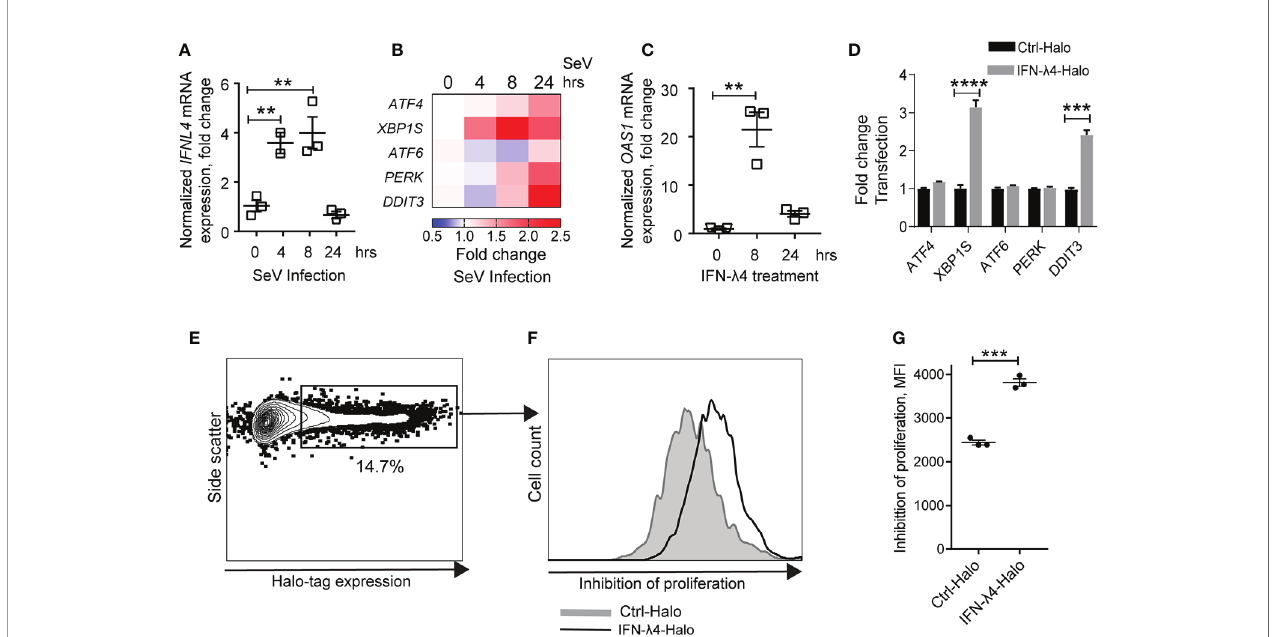
FIGURE 3 | IFN- l 4 inhibits the proliferation of hepatic stellate cells (HSCs). qRT-PCR expression analysis showing (A) IFNL4 expression after SeV infection of primary HSCs and (B) induction of UPR markers . (C) qRT-PCR showing induction of OAS1 after treatment of primary HSCs with recombinant IFN- l 4 (50ng/ml). (D) qRT-PCR showing induction of UPR markers in LX-2 hepatic stellate cell line transiently transfected for 24 hrs with Halo-tagged constructs for IFN- l 4 or control. (E – G) Proliferation analysis in LX-2 cells transiently transfected with Halo-tagged constructs for IFN- l 4 or control, labeled with Far Red proliferation dye and analyzed by fl ow cytometry after 72 hrs. (E) Gating for Halo-tag expression. (F) Histogram representing the proliferation of gated cells, comparing cells expressing Halo- tagged IFN- l 4 vs. control. (G) Graph representing the geometric mean expression of Far Red proliferation dye with higher values indicating reduced proliferation. **p < 0.01, ***p < 0.001, ****p < 0.0001, Student ’ s